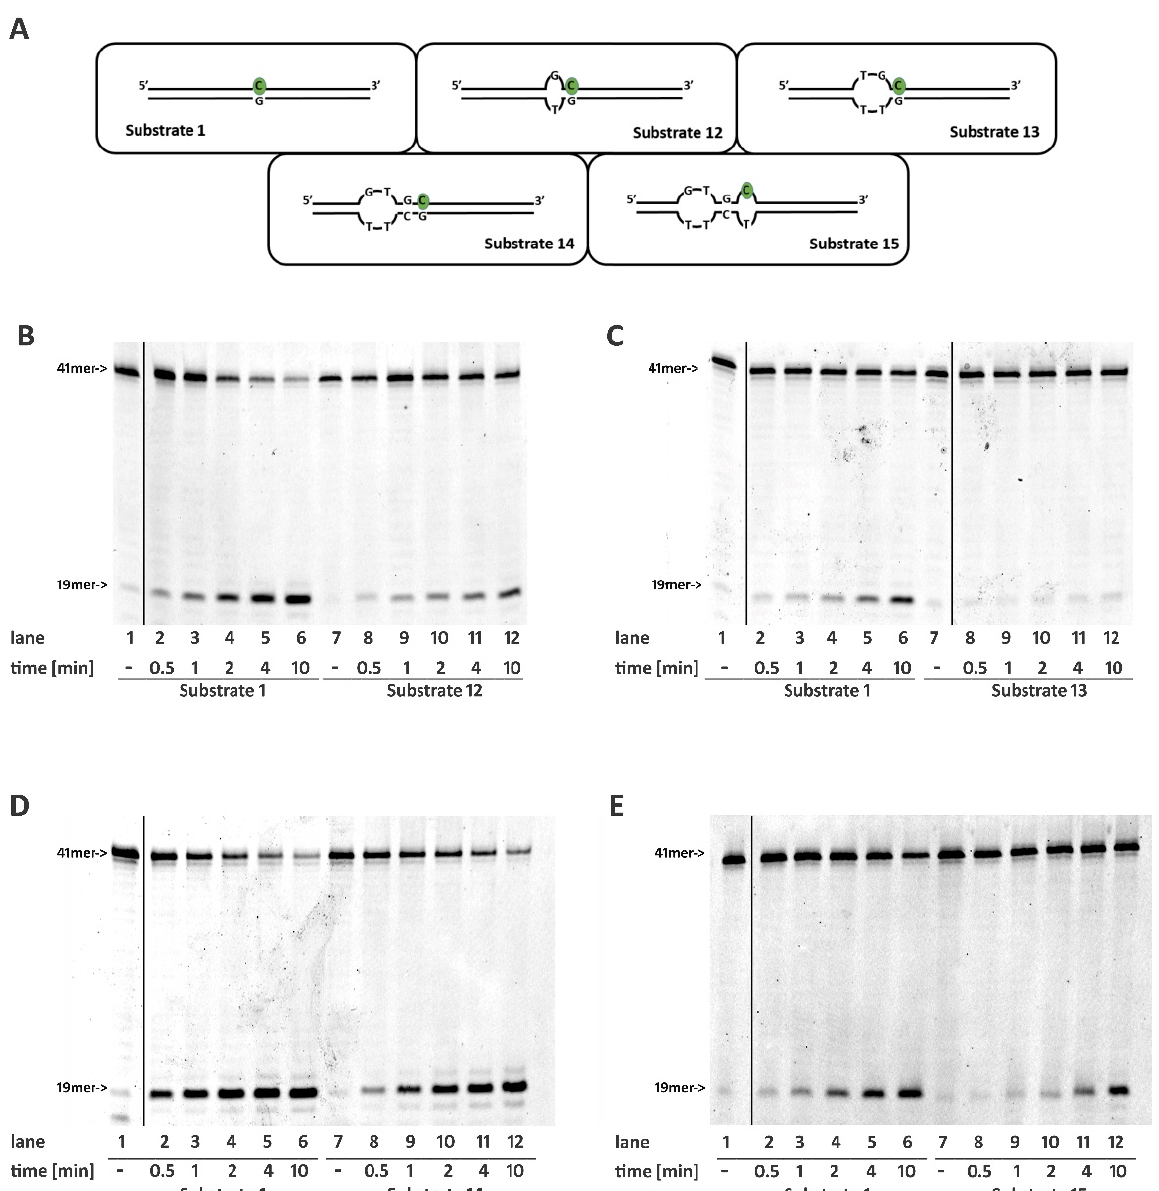
Figure 3. Correct pairing of the two nucleotides flanking the 5 ′ of the embedded ribonucleotide is essential for RNase H2 activity. Time course reactions were performed as described in materials and methods using 20 nM nucleic acid substrates and 0.4 nM RNaseH2. ( A ) Schematic representation of substrates used. Enzyme activity was compared between ( B ) Substrates 1 and 12; ( C ) Substrates 1 and 13; ( D ) Substrates 1 and 14; ( E ) Substrates 1 and 15. Unprocessed substrates and reaction products are indicated at the left of each panel (41mer and 19mer respectively). Black vertical lines represent cropped areas in the raw pictures.